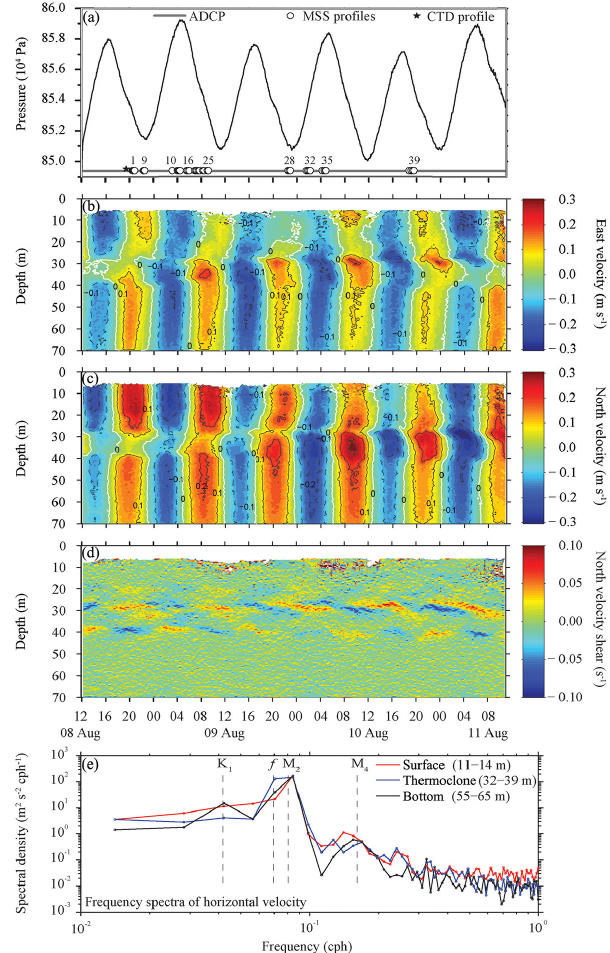
Figure 3. Current regime at the Tommeliten site from ADCP mea- surements (a–d) and spectral analysis (e) . (a) Sea surface eleva- tion relative to average level during the observational period (el- evation = 0m) and schedule of different instrument deployments. Numbers on the MSS markers indicate the profile number. (b, c) Horizontal velocities, showing 20min averaged east (b) and north (c) velocities. (d) Vertical shear of north velocity, d v /d z , calculated from the ADCP velocity data (see panels b , c ). Note that panels (a–d) have the same time axis. (e) Frequency spectra of horizontal velocity calculated from the ADCP data for selected depth ranges for the SBL (surface; red line), thermocline (blue line) and BBL (bottom; black line). The inertial frequency, f , and the frequency for the diurnal declination tide, K 1 , semi-diurnal lunar tide, M 2 , and shallow water tidal constituent, M 4 , are